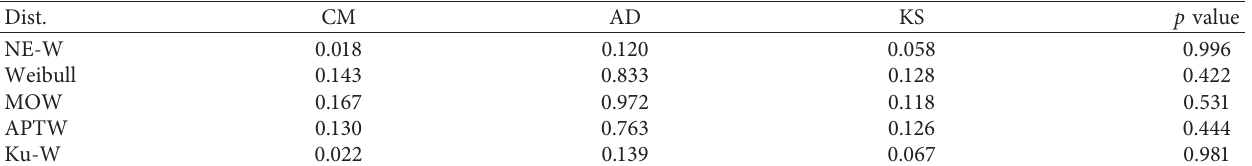
Table 8: Goodness of fit measures of the fitted models for data